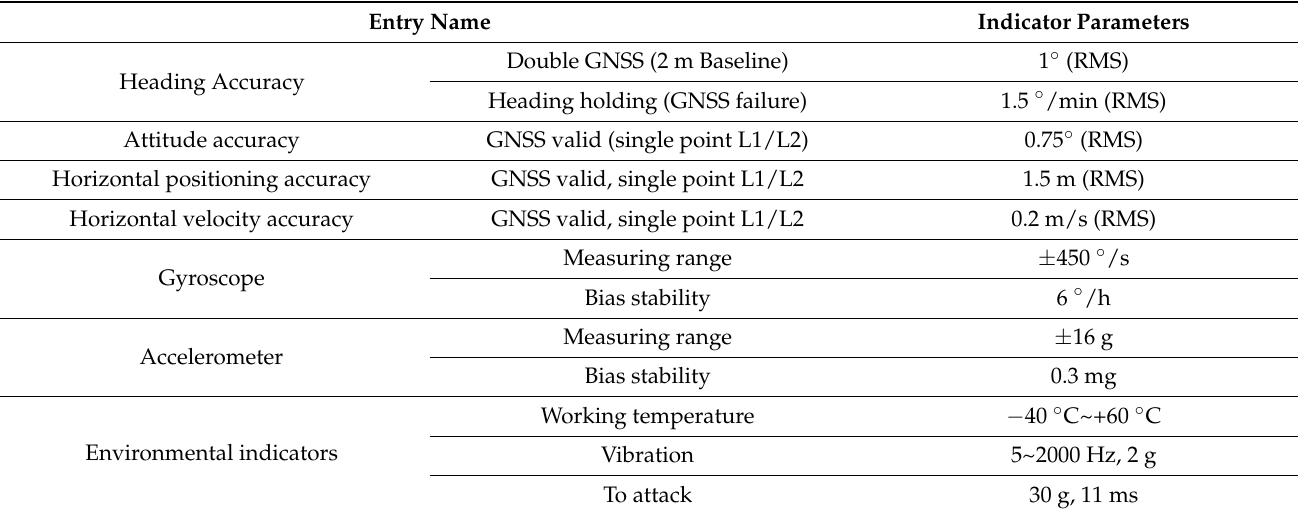
Table 1. Main index requirements for an integrated navigation system.